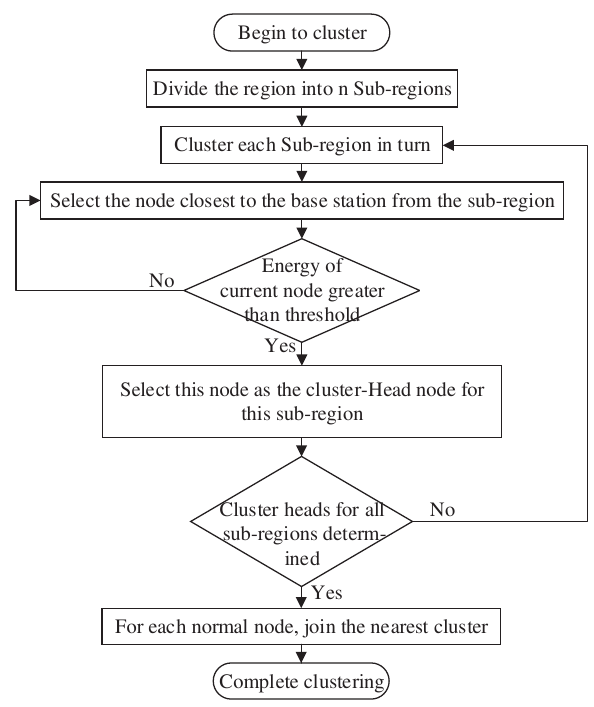
Figure 4. Normal node cluster establishment